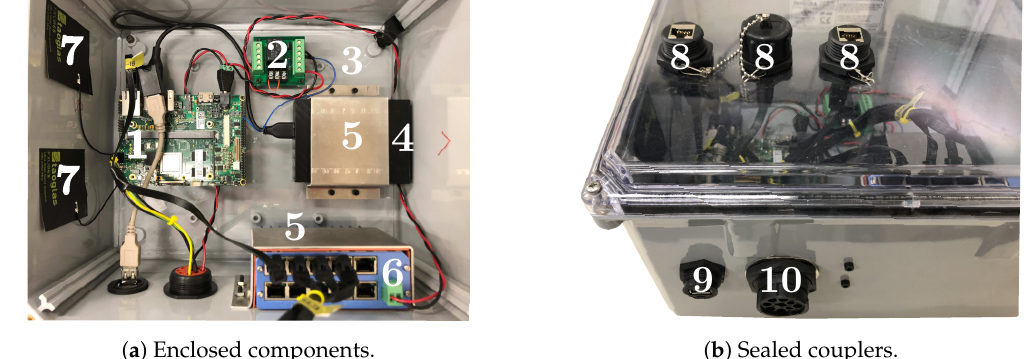
Figure 6. Hardware components are housed in a sealed enclosure to withstand dust and vibrations, as shown in ( a ). Couplers shown in ( b ) provide sealed connections between internal and external components. The annotated components are: (1) single board computer (2) relay PCB (3) plexiglass base (4) USB hard drive (5) anti-vibration straps (6) PoE switch (7) cellular antennas (8) Ethernet couplers (9) USB coupler and (10) ISOBUS coupler.